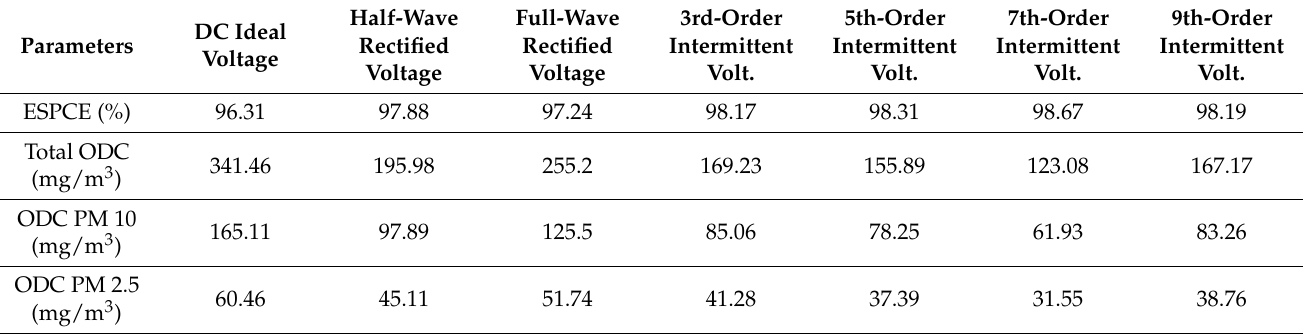
Table 14. Dust particle collection for various types of supply voltages without rapping; the dust resistivity is 10 12 Ω ·